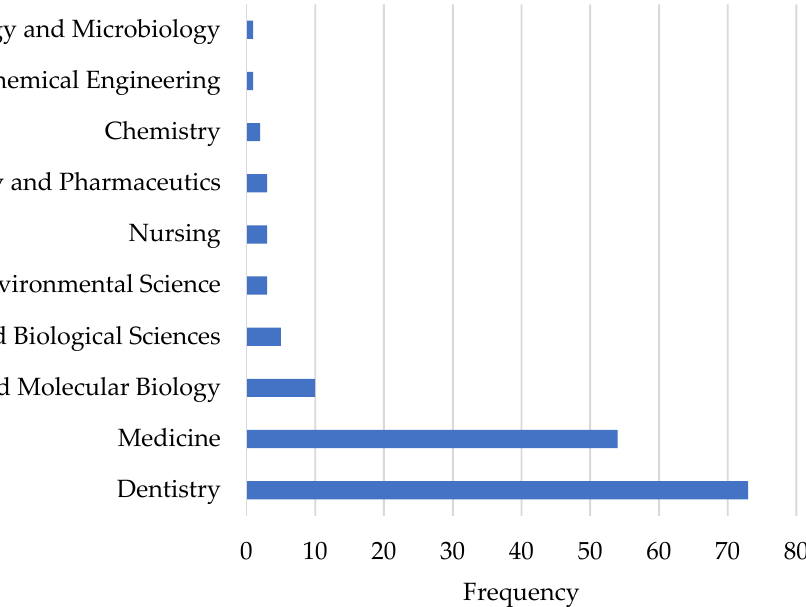
Figure 4. Distribution of original research articles by subject area.